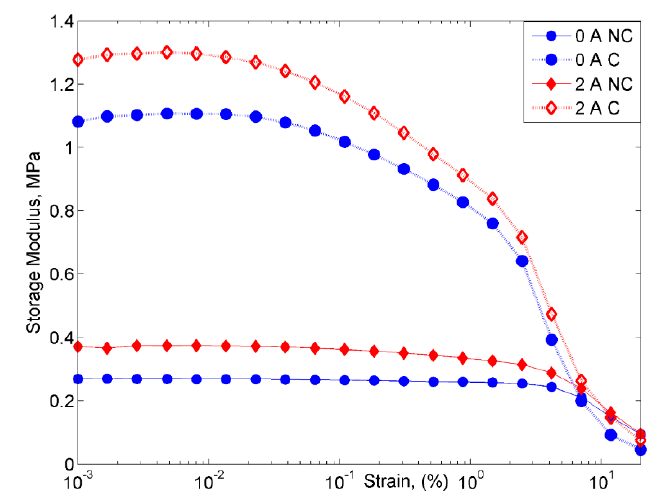
Figure 10. Comparison of storage modulus vs. strain for MRE samples of non-corroded (NC) and corroded (C) CIPs at off- and on-state conditions.